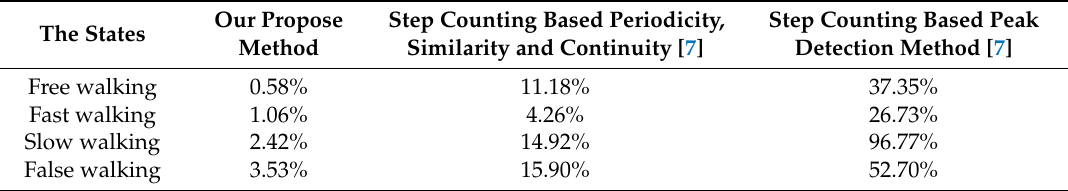
Table 5. The average errors among our proposed method and two methods presented in Reference